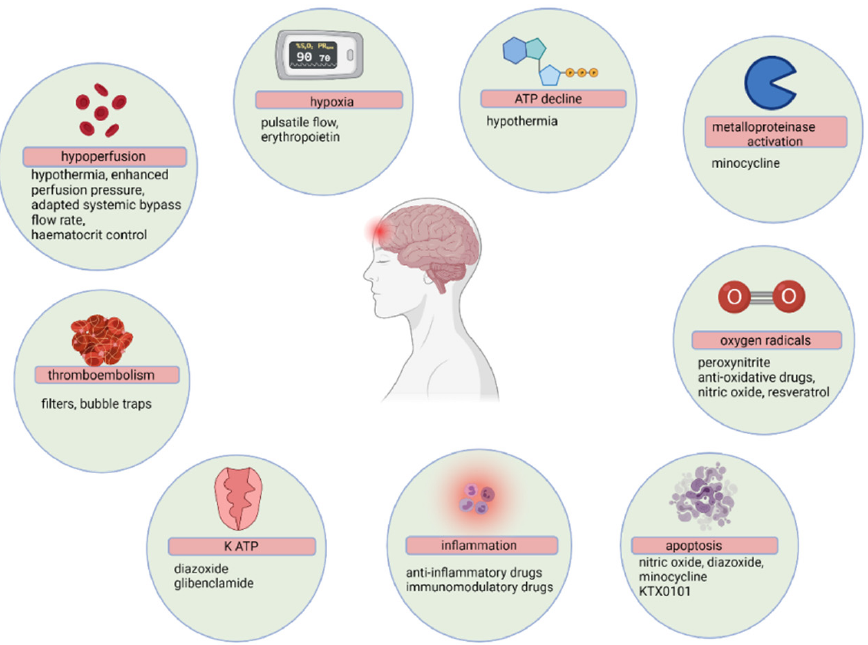
Figure 3. Pathophysiology of the neurological deficit during cardiopulmonary bypass graft surgery. Red bars indicates adverse effects, and green circles reflect proposed neuroprotective